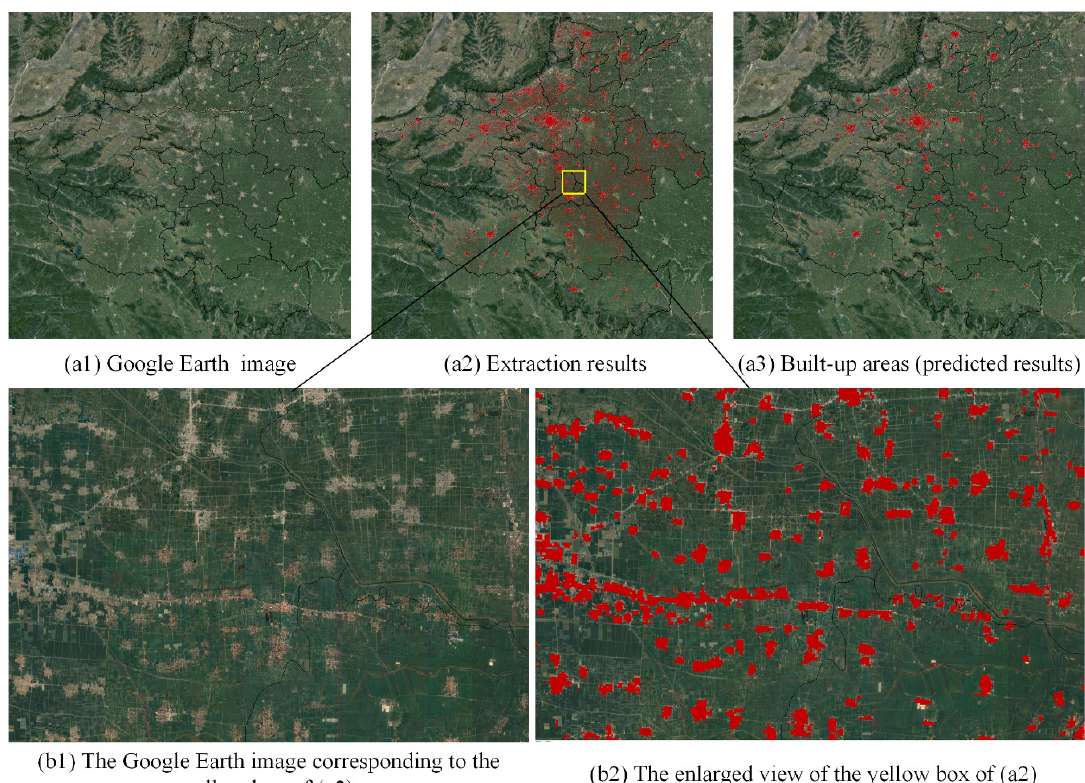
Figure 10. Extraction results of Henan Province and the corresponding Google Earth image.